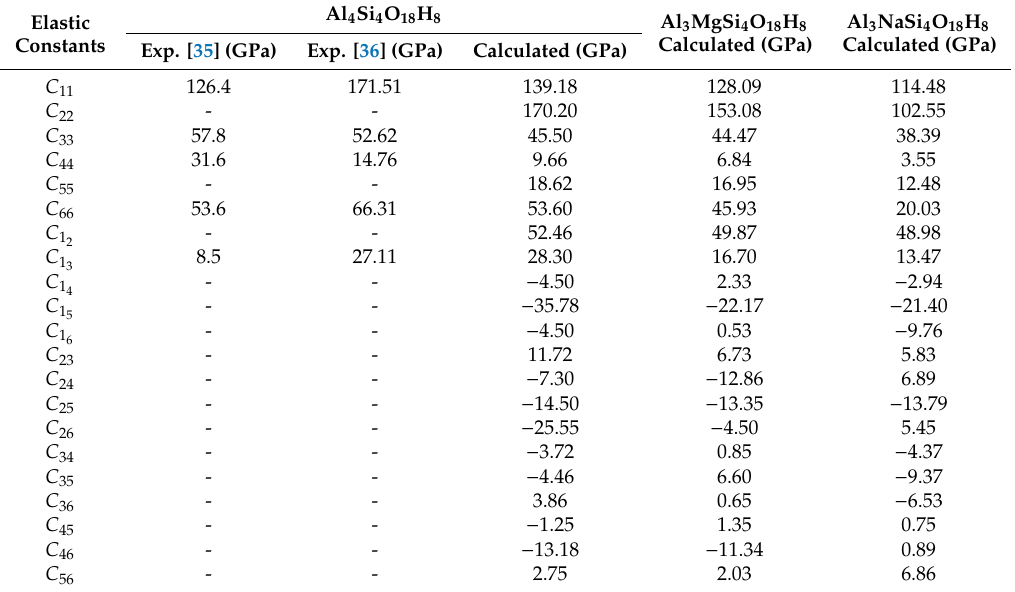
Table 4. The calculated elastic constants of the undoped kaolinite (Al 4 Si 4 O 18 H 8 ), Mg-doped kaolinite,